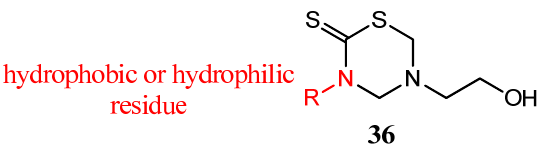
Figure 12. 3-Substituted-5-(2-hydroxyethyl)-THTT derivatives.